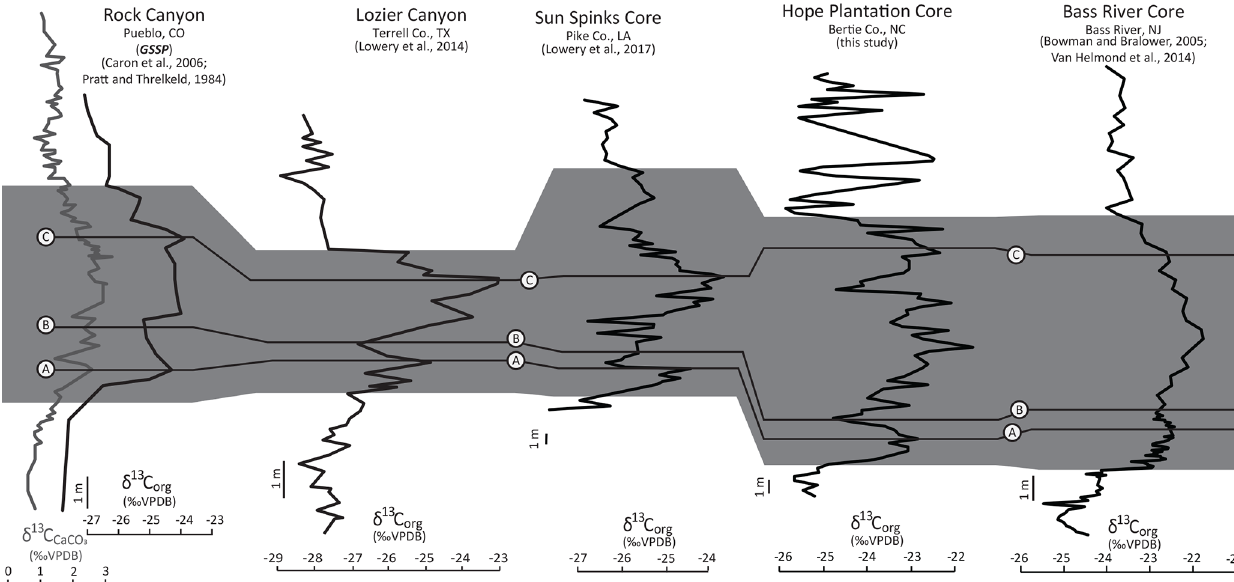
Figure 7. Comparison of North American carbon isotope curves from the Cenomanian–Turonian Global Stratotype Section and Point at Rock Canyon in Pueblo, CO; Lozier Canyon in Terrell Co., TX, near the transition from the Western Interior Seaway to the Gulf of Mexico; the Sun Spinks core in Pike Co., LA, on the Gulf Coastal Plain; the Hope Plantation core from Bertie Co., NC, on the Atlantic Coastal Plain; and the Bass River core from Bass River, NJ, on the Atlantic Coastal Plain. The Rock Canyon record includes both bulk carbonate (gray line) and organic carbon (black line) isotopes; all other sites only show organic carbon isotopes. The position of the A–B–C peaks (first identified by Pratt and Threlkeld, 1984) is traced between the cores. The gray bar shows the extent of OAE2 in each core.